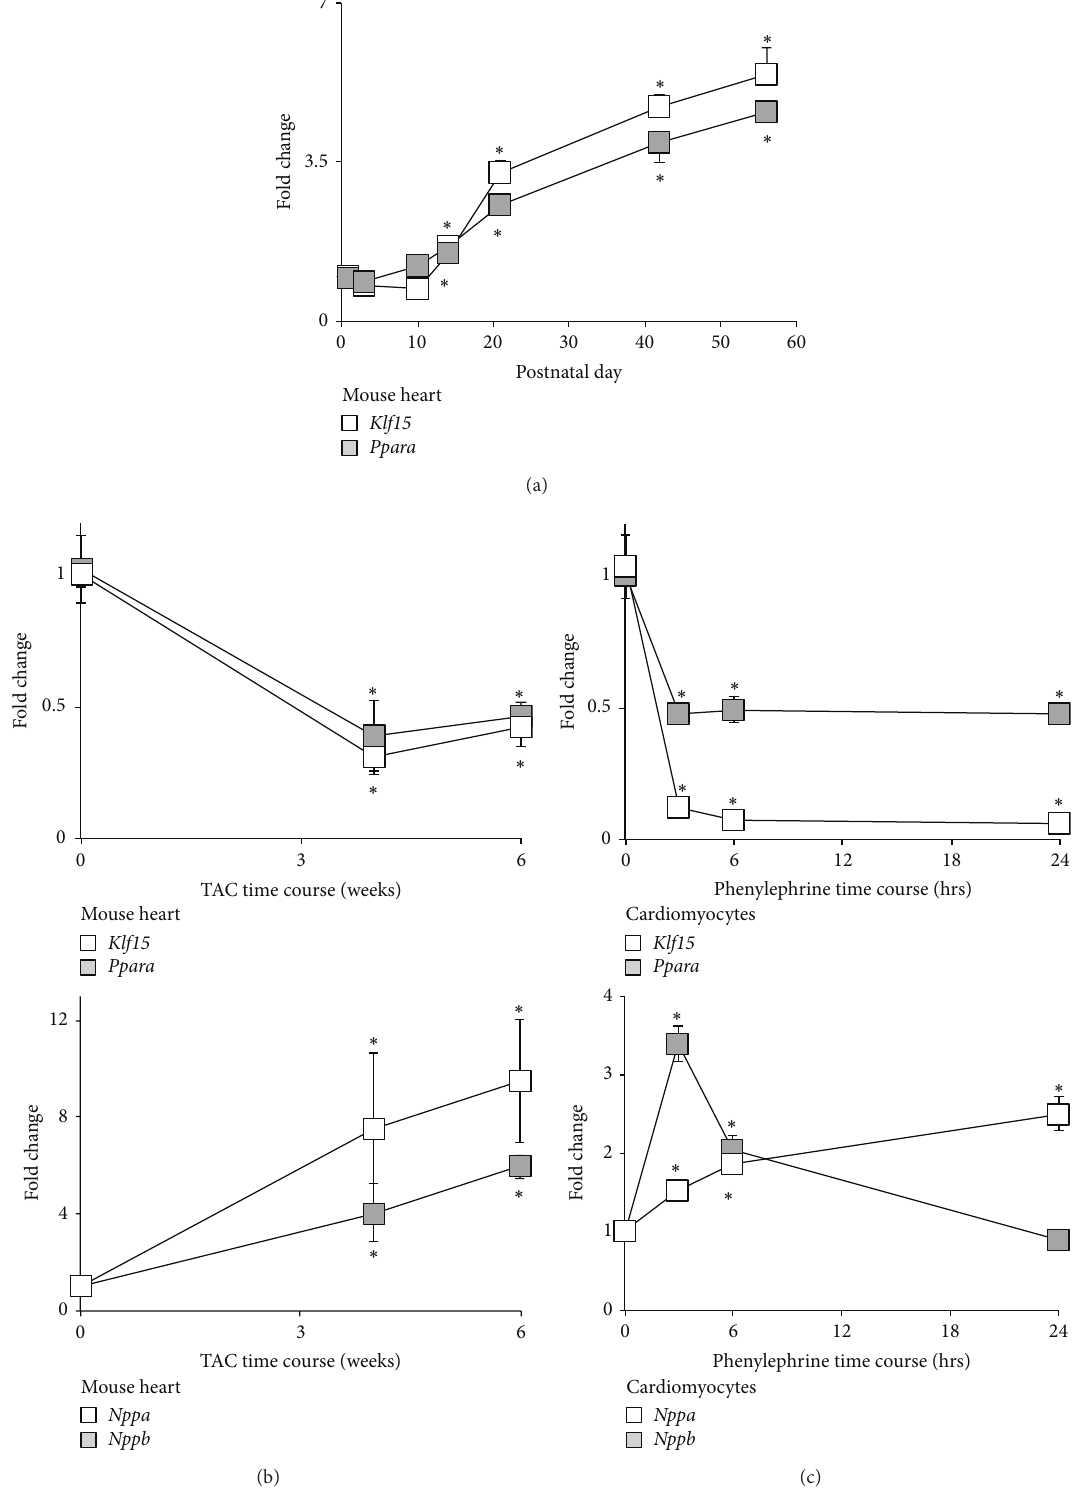
Figure 1: Expression of KLF15 and PPAR 𝛼 are regulated by physiological and pathological stimuli. (a) Klf15 and Ppara expression in mouse heart during postnatal maturation ( 𝑛 = 4 ). ∗ 𝑃 < 0.05 versus day 1. (b) Klf15 and Ppara (top panel) and Nppa/ANF and Nppb/BNP (bottom panel) expression in murine heart tissue in sham ( t = 0 weeks) versus transaortic constriction (TAC) at multiple time points ( n = 3-4). ∗ 𝑃 < 0.05 versus sham. (c) Klf15 and Ppara (top panel) and Nppa/ANF and Nppb/BNP (bottom panel) expression in neonatal rat ventricular cardiomyocytes following exogenous addition of vehicle ( t = 0 hours) versus phenylephrine (100 𝜇 M) at multiple time points ( 𝑛 = 6 ). ∗ 𝑃 < 0.05 versus vehicle. Values normalized to cyclophilin-B ( Ppib